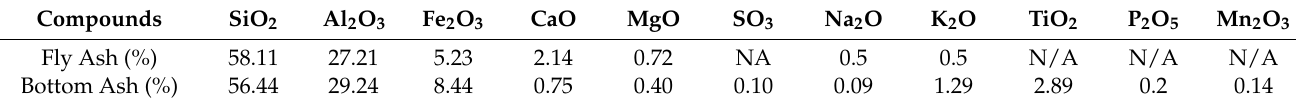
Table 3. Chemical composition of by-products (source: Bathinda coal power plant).